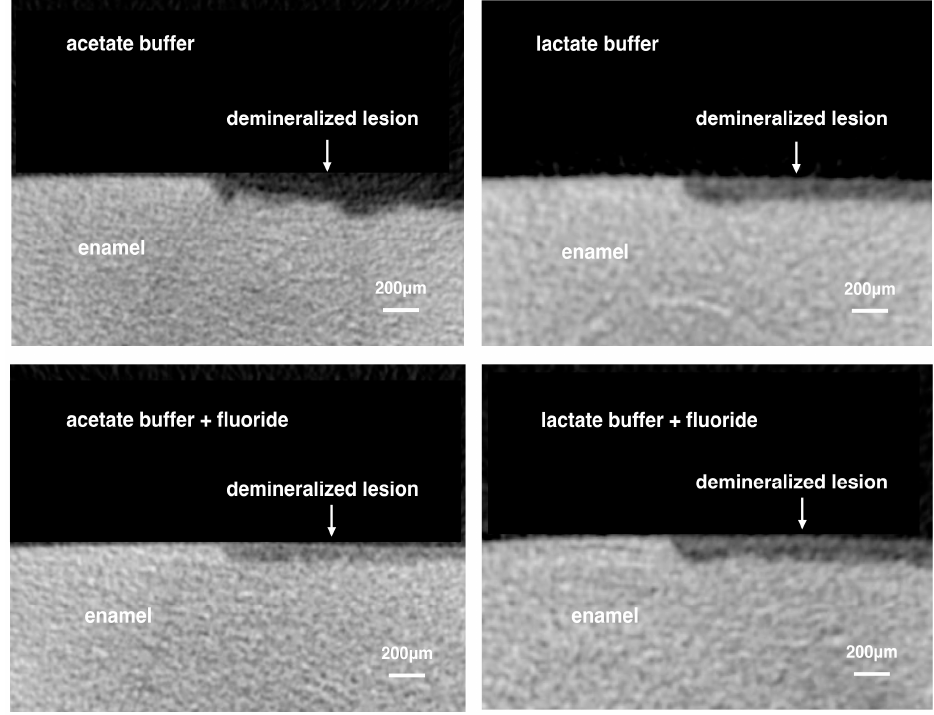
Figure 1. Representative images of reconstructed micro-computed tomography of the four experimental groups.